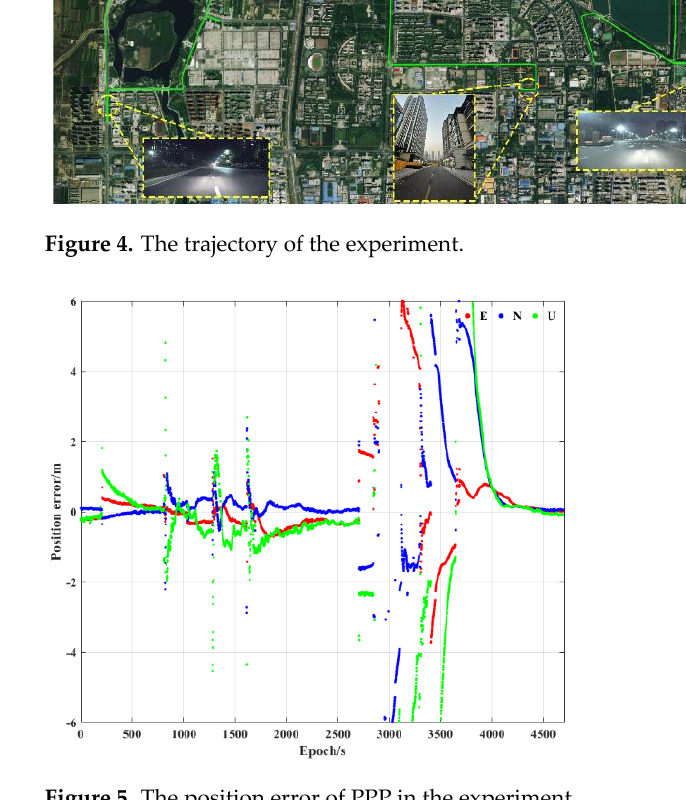
Table 1. Precision specifications of the above IMUs utilized in the